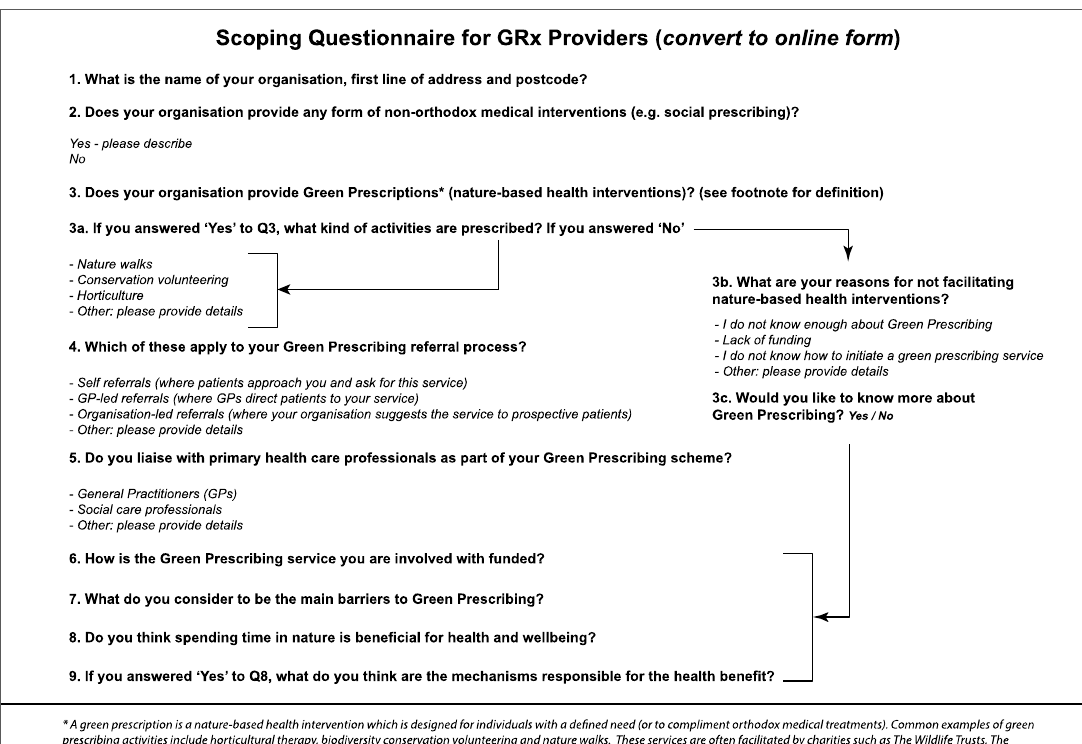
Figure A1. Green prescribing questionnaire for GPs.